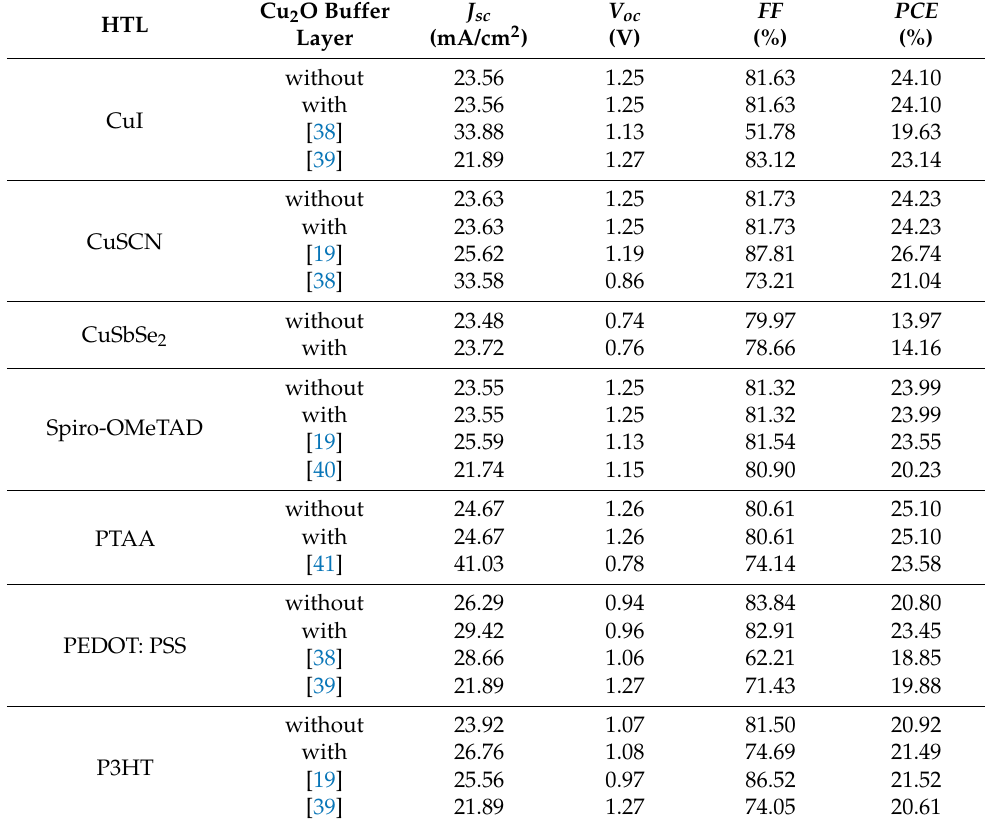
Table 2. Photovoltaic parameters obtained using different HTMs by using an Au electrode (with and without Cu 2